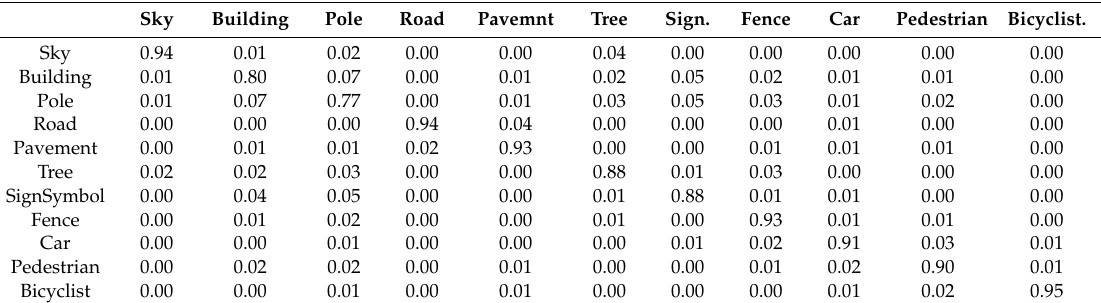
Figure 5. ( a ) Sampling points and ( b ) segmentation samples. Table 1. Confusion matrix for network validation .